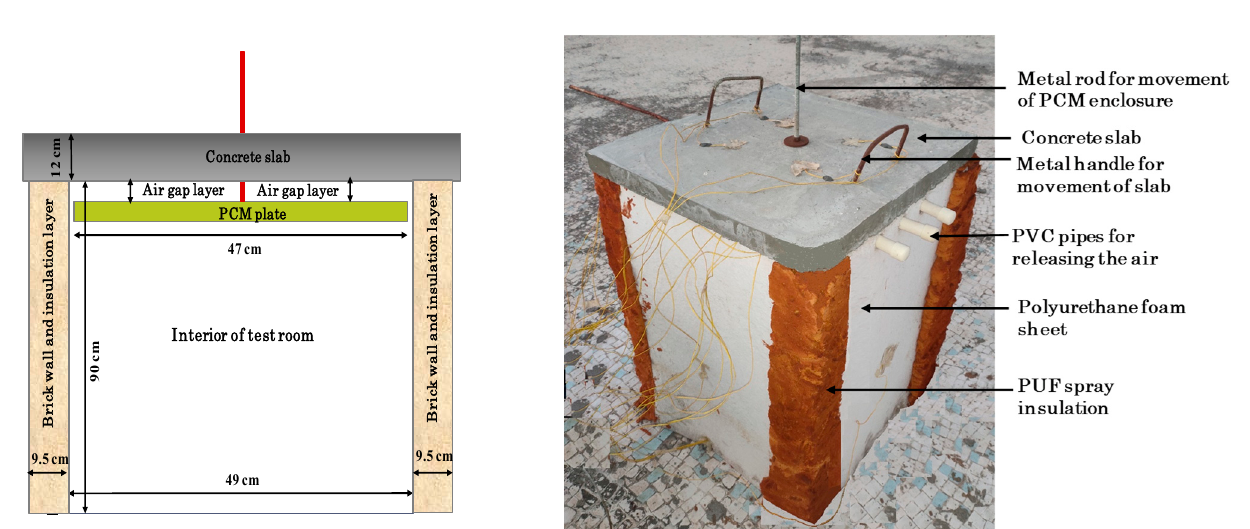
Figure 1. Details of PCM enclosure in the test room.